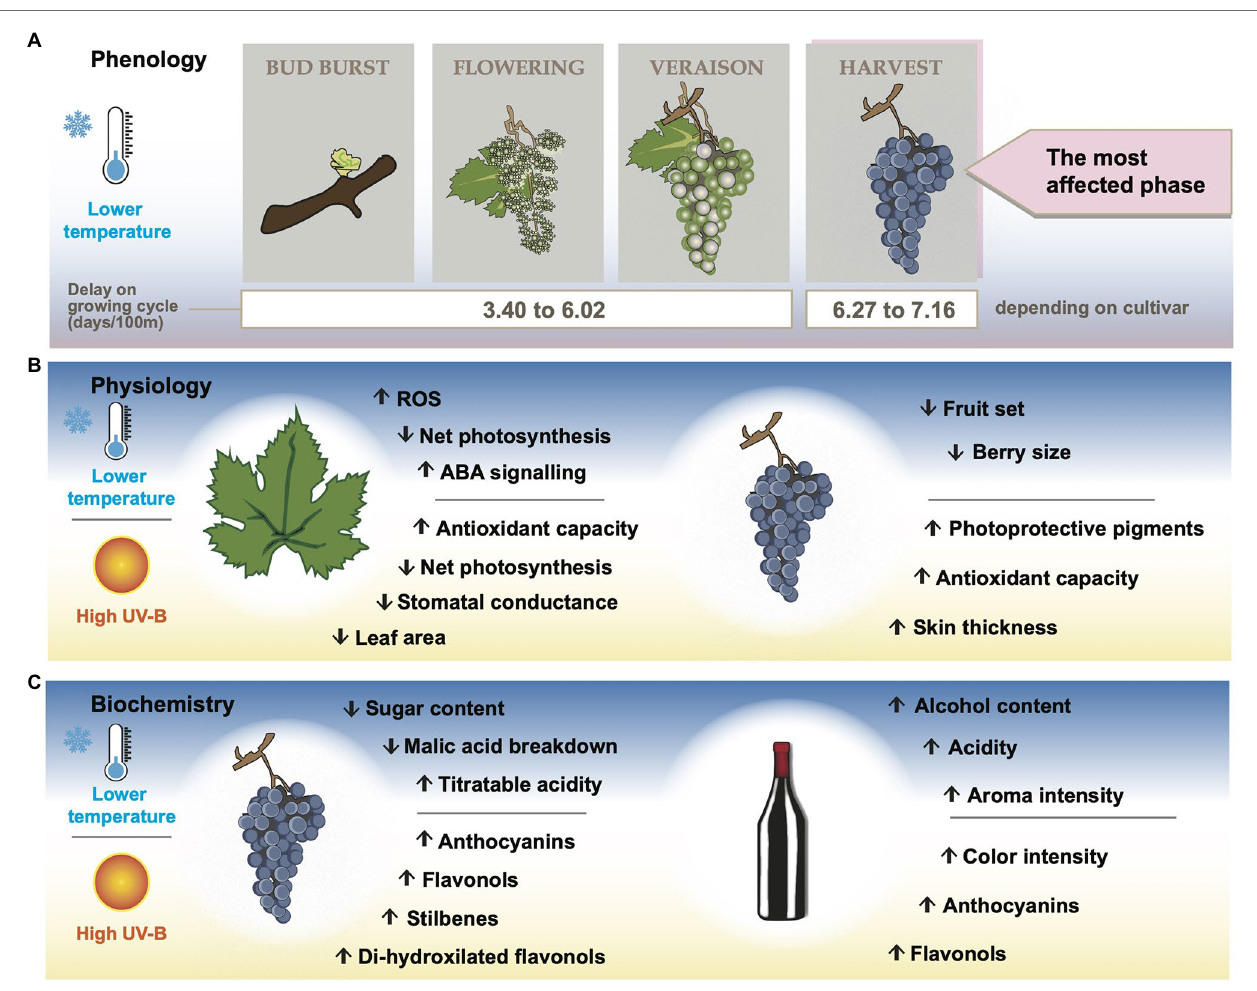
FIGURE 2 | Effects of low temperature and high UV-B at higher altitude vineyards on grapevine phenology (A) , physiology (B) , grape biochemistry, and wine chemical composition (C)